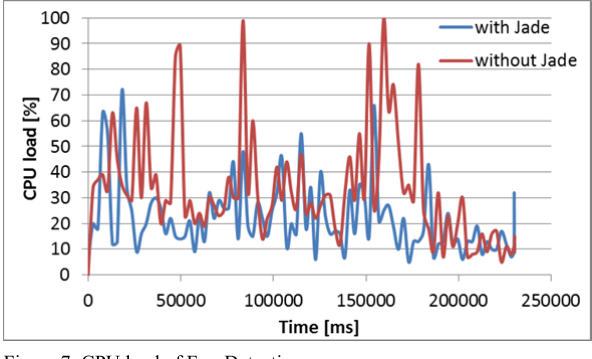
Figure 7: CPU load of FaceDetection